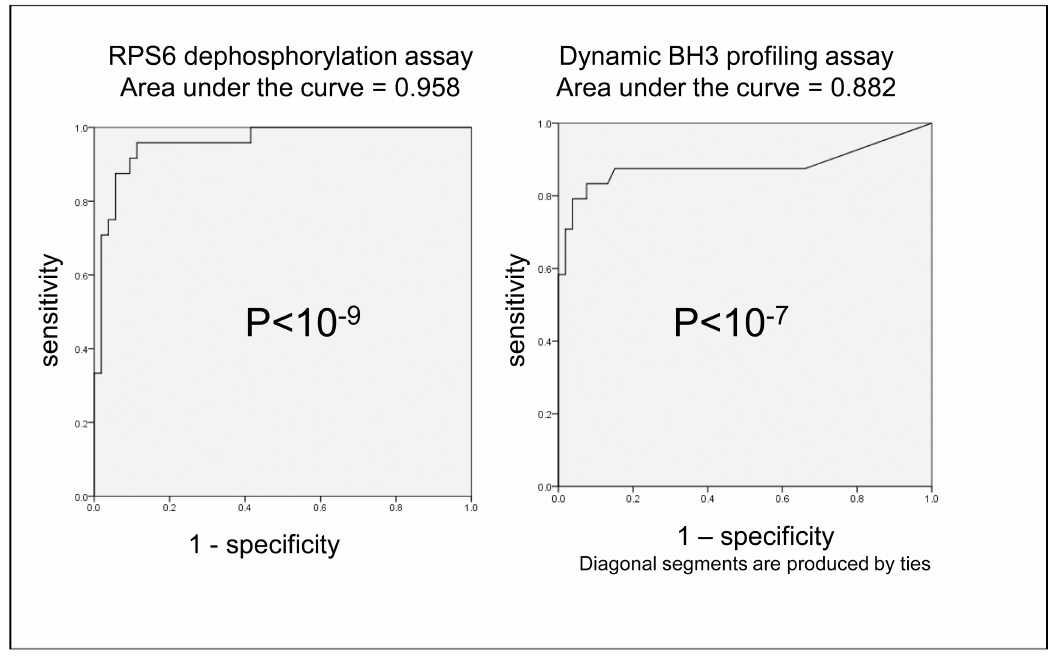
Fig 4. ROC curve analysis confirms highly significant overall sensitivity and specificity for the ability of both rpS6 dephosphorylation and PUMA-BH3 induced cytochrome C release after 4 hours drug treatment to predict 48 hour sensitivity to drugs. Summary ROC curves for percent change in rpS6 phosphorylation and PUMA induced cytochrome c release after 4 hours treatment with 1 μ M etoposide, 50nM sorafenib, 600ng/ml GO, 10nM AC220, 1 μ M vosaroxin, 500nM 17-AAG or 2 μ M cytarabine in 11 AML cells lines. Cell lines were classified as sensitive or resistant according to 48 hours drug response (The standardised definition of sensitivity is described in the methods section). Each data point used to generate the analysis is the mean of three individual